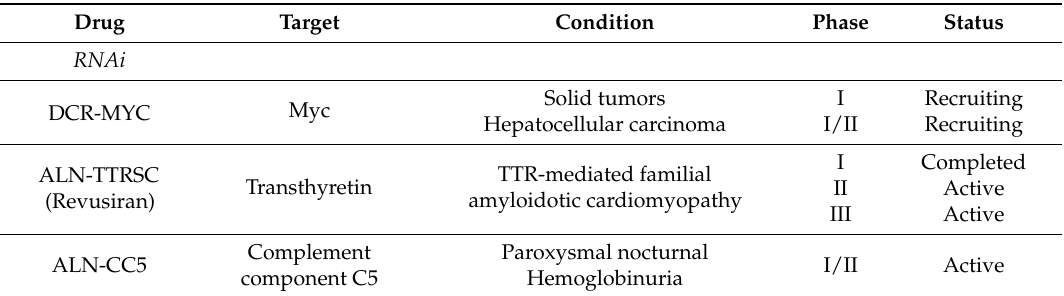
Table 1. Summary table of clinical trials currently active for selected small interfering RNA (siRNA) and antisense therapeutics (adapted from